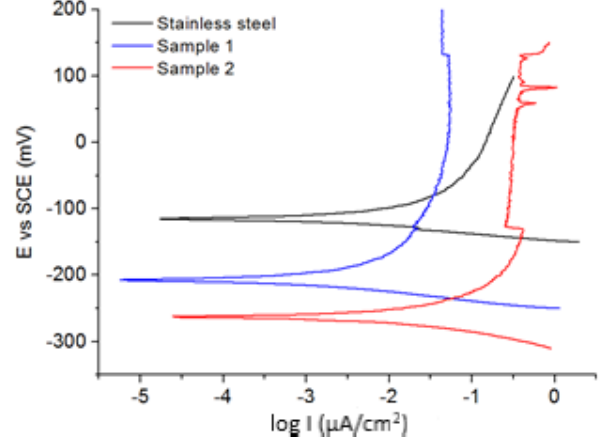
Figure 4. Polarization curve obtained in 0.1 M NaCl for bare stainless steel, sample 1 and sample 2. Table 2. Corrosion parameters for bare and nitriding stainless steel in 0.1 M NaCl determined by Tafel extrapolation method.